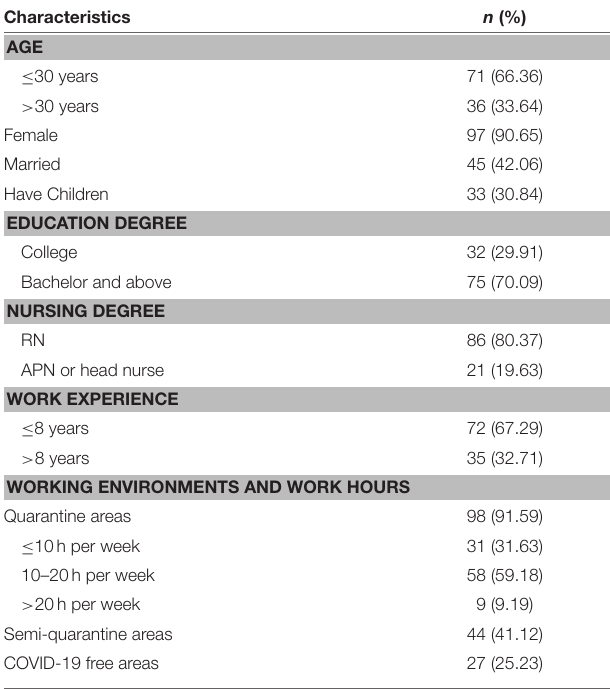
TABLE 1 | Characteristics of participants ( n =